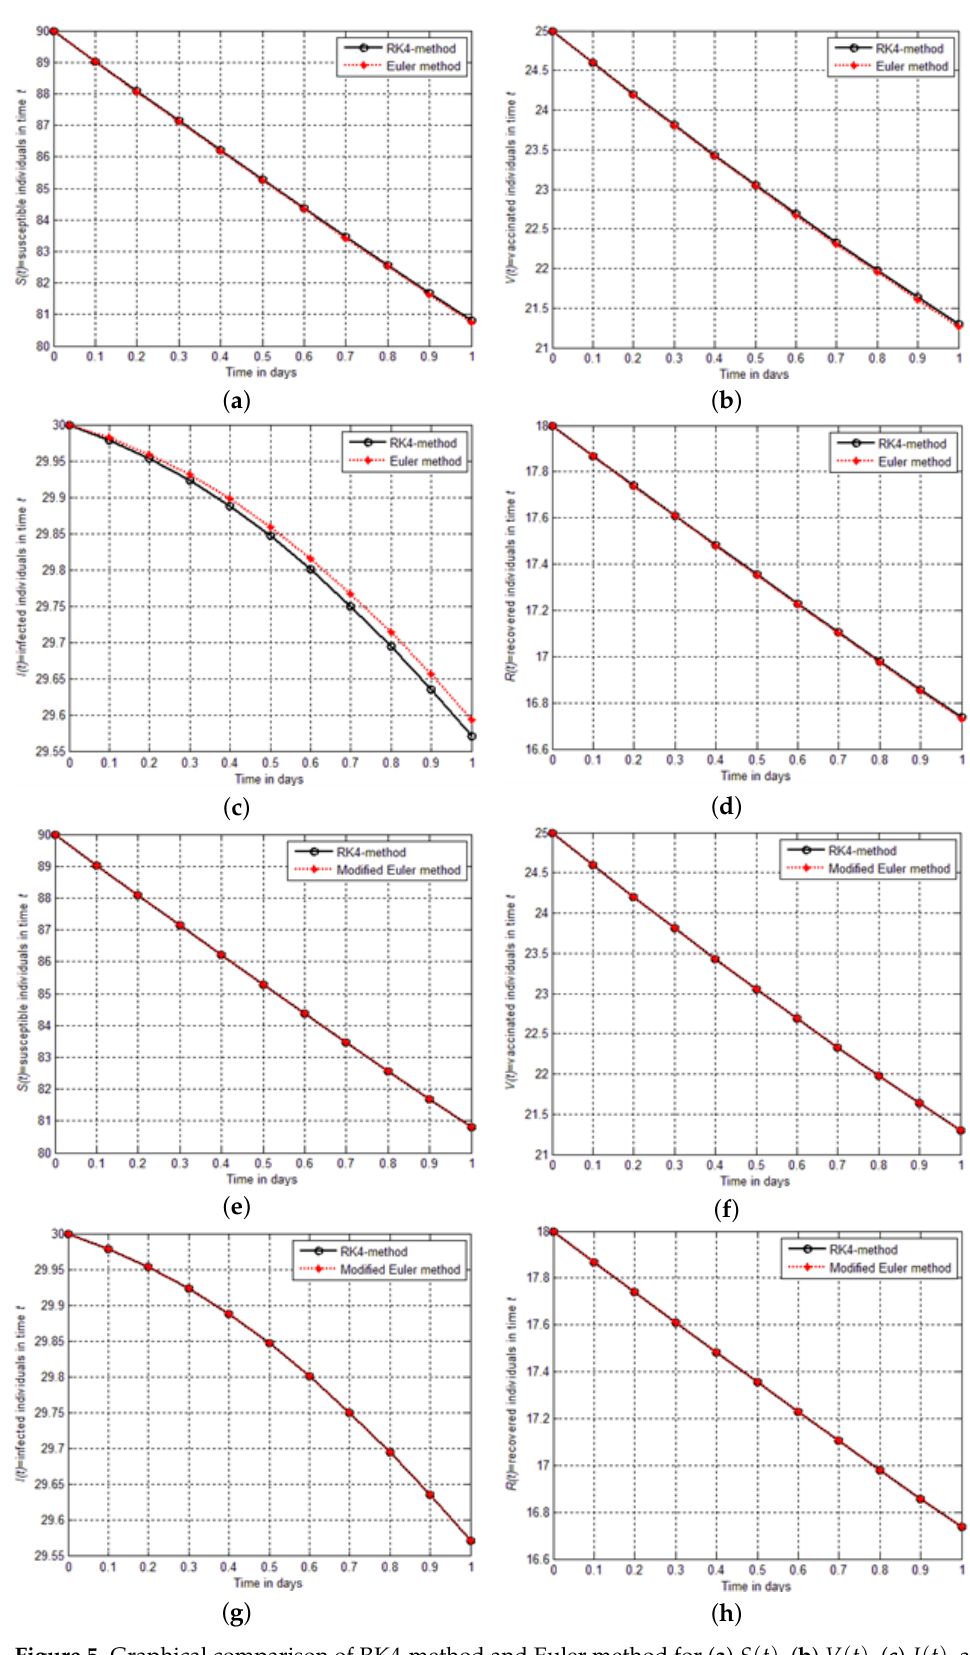
Figure 5. Graphical comparison of RK4-method and Euler method for ( a ) S ( t ) , ( b ) V ( t ) , ( c ) I ( t ) , and ( d ) R ( t ) . Numerical comparison of RK-4 method and modified Euler method for ( e ) S ( t ) , ( f ) V ( t ) , ( g ) I ( t ) , and ( h ) R ( t )